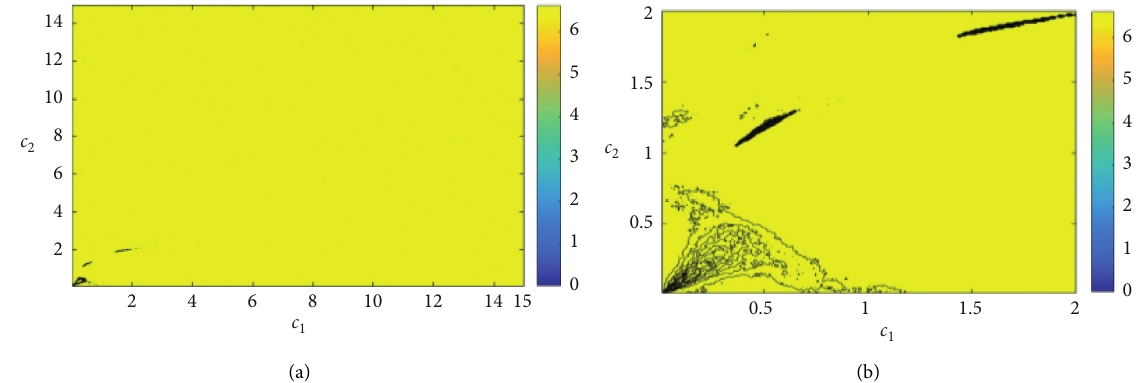
Figure 1: The approximate entropy of the control parameters of c